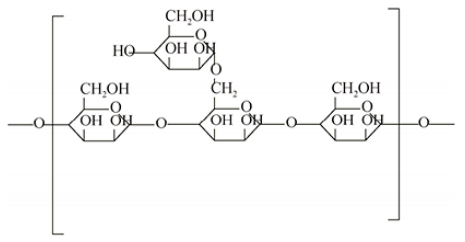
Figure 2. Chemical structure of guar gum.